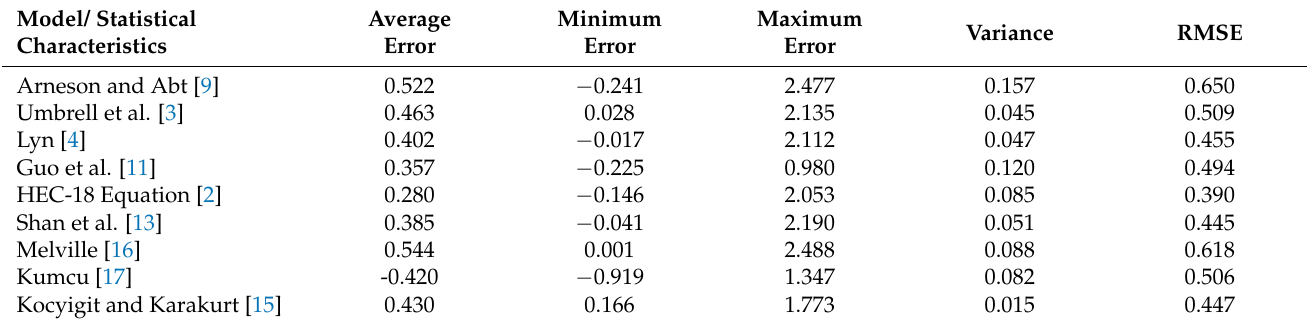
Table 4. Error statistics for different models using current laboratory data